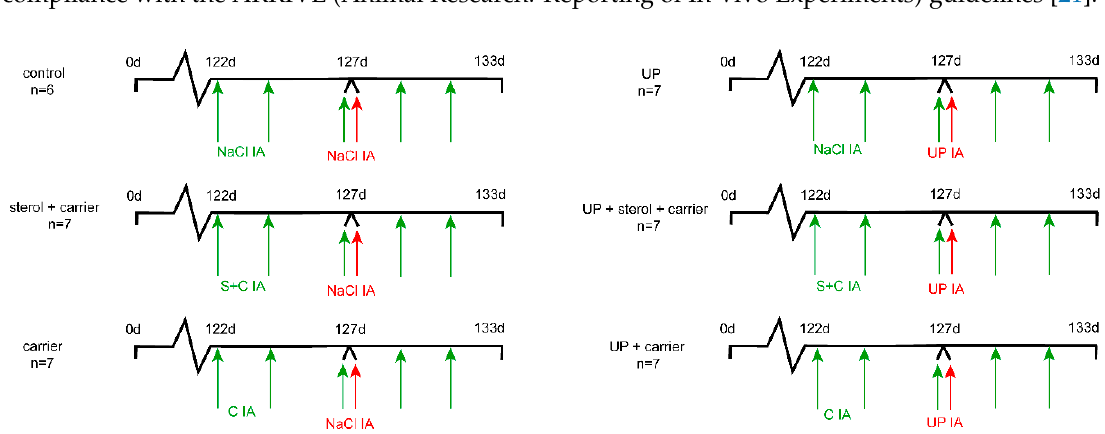
Figure 1. Experimental design. Animals were randomly assigned to six study groups of six to seven animals. Plant sterols dissolved with a carrier (C) ( β -cyclodextrin) were given by intra-amniotic (IA) injection at 122 d of gestational age (GA), before onset of chorioamnionitis. Plant sterol injections were repeated every 2 days until 131 d GA, followed by premature delivery at 133 d GA. U. parvum serovar 3 (10 7 color changing units (CCUs)) was given by IA injection at 127 d GA to induce chorioamnionitis. Control groups had saline injections. Two groups received the carrier ( β -cyclodextrin) IA without plant sterols to assess the carrier separately from the plant sterols. Abbreviations: C, carrier; IA, intra-amniotic; S, plant sterols; UP, U. parvum .